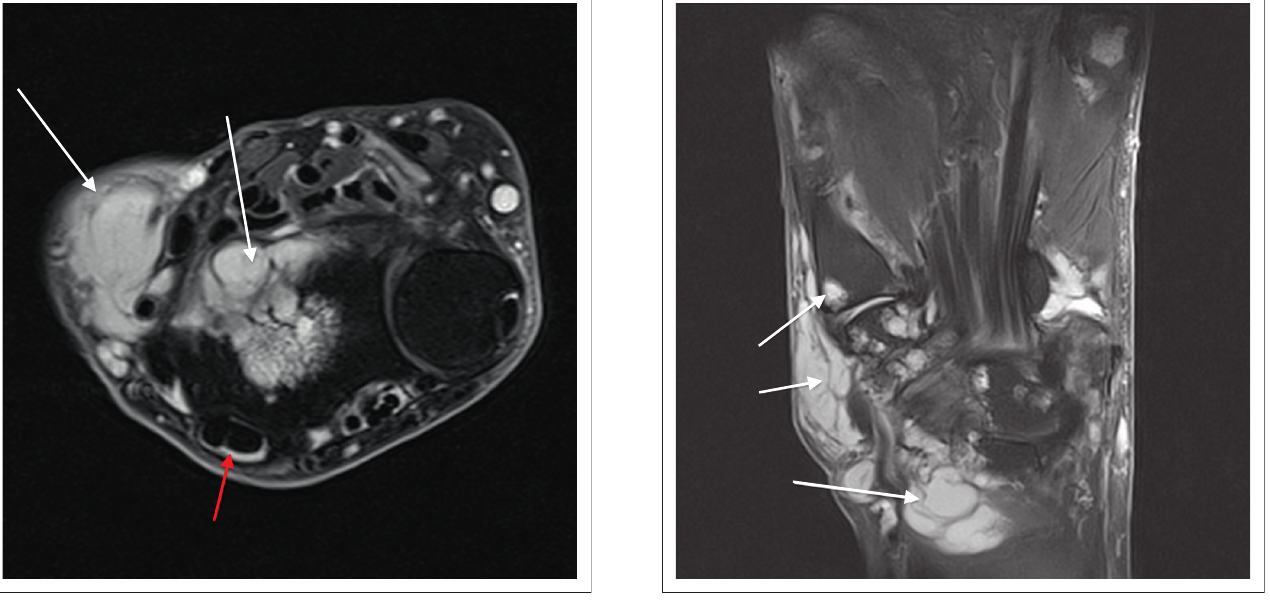
(cid:258) (cid:271)